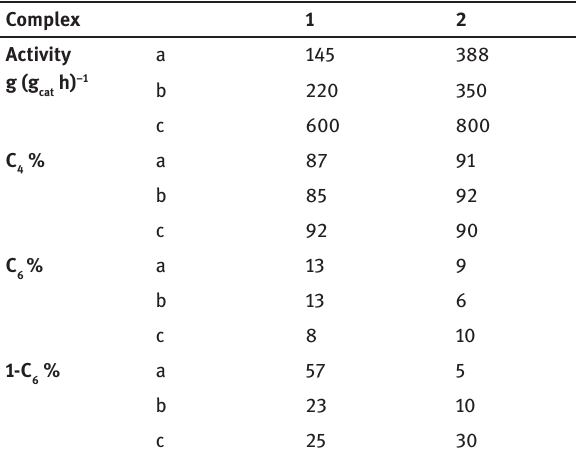
All percentages are by mass. The fraction 1-C is given as a 6 percentage of the C total fraction. Experiments a and b were 6 performed under low ethylene pressure (1 bar), whereas experiments c under 10 bar of ethylene